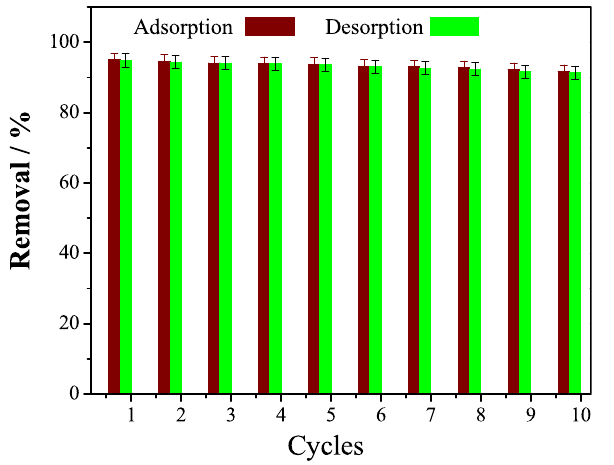
Figure 8. Adsorption–desorption cycles.